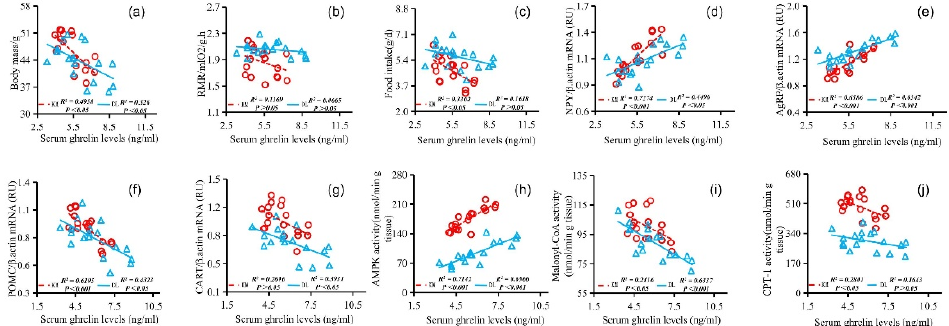
Figure 7. Correlation between serum ghrelin concentration and body mass ( a ), RMR ( b ), food intake ( c ), NPY gene expression ( d ), AgRP gene expression ( e ), POMC gene expression ( f ), CART gene expression ( g ), AMPK activity ( h ), malonyl CoA activity ( i ), and CPT-1 activity ( j ) in E. miletus under food restriction.